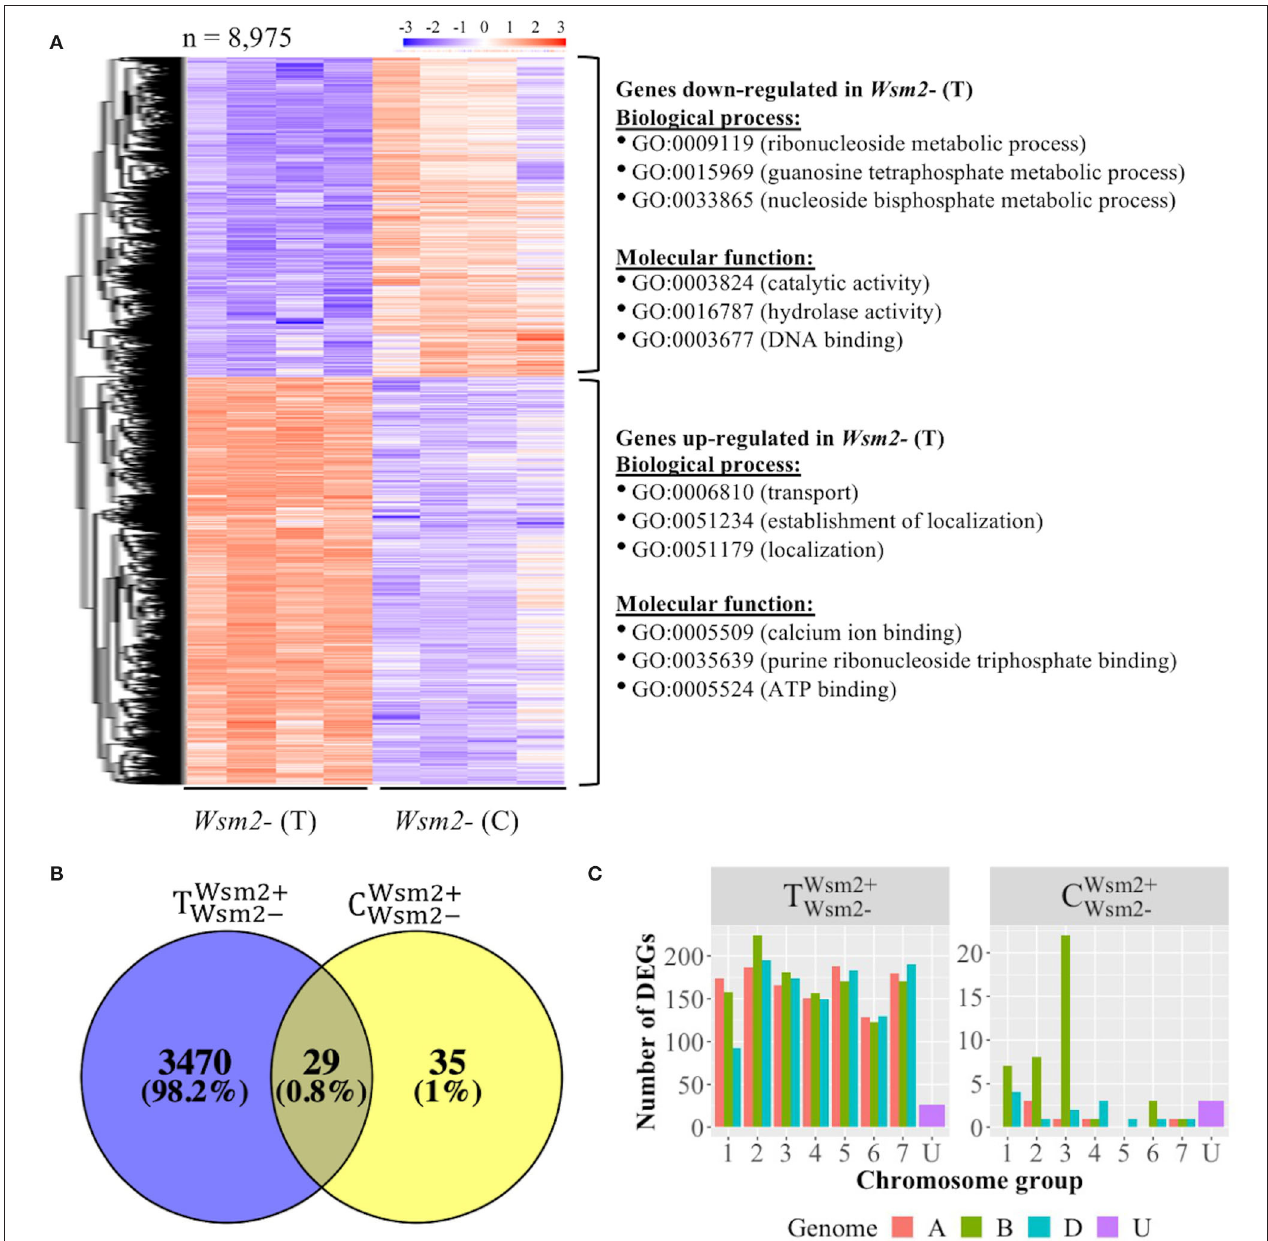
FIGURE 5 | Overview of differentially expressed genes (DEGs) between mock (C) and WSMV (T) treatments, and between Wsm2 + and Wsm2 - genotypes using IWGSC RefSeq v1.0 as a mapping reference. (A) Heatmap of 8,975 DEGs from the comparison of Wsm2 - (C) vs. Wsm2 - (T) samples. The expression values are normalized by setting the mean of every row to zero and the standard deviation of every row to one. Hierarchical clustering separated these into DEGs that are either upregulated ( n = 5,031) or downregulated ( n = 3,944) in WSMV-treated conditions. The top three enriched GO terms (biological process and molecular function) for each row cluster are shown on the right. (B) Venn diagram of total DEGs ( P adj < 0.01) between genotypes ( T Wsm 2 + Wsm 2 − and C Wsm 2 + Wsm 2 − ). (C) Number of DEGs comparing Wsm2 + (T) vs. Wsm2 - (T) and Wsm2 + (C) vs. Wsm2 - (C) conditions, based on each gene’s chromosomal location. A, B, D, and unknown genomes are